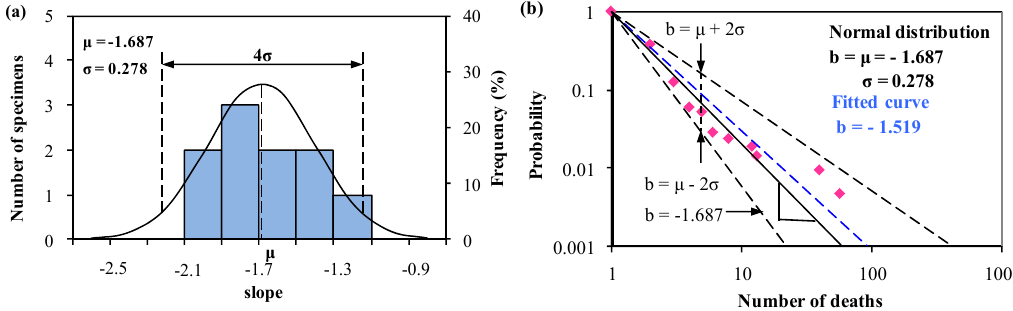
Figure 7. ( a ) Normal distribution analysis of the slope bi determining the relation between the accumulated frequency and number of deaths, and ( b ) predictions from Equation (1) and Equation (3) based on the normal distribution analysis of b i in ( a ) together with the statistical data from 2013 to 2017 in China.